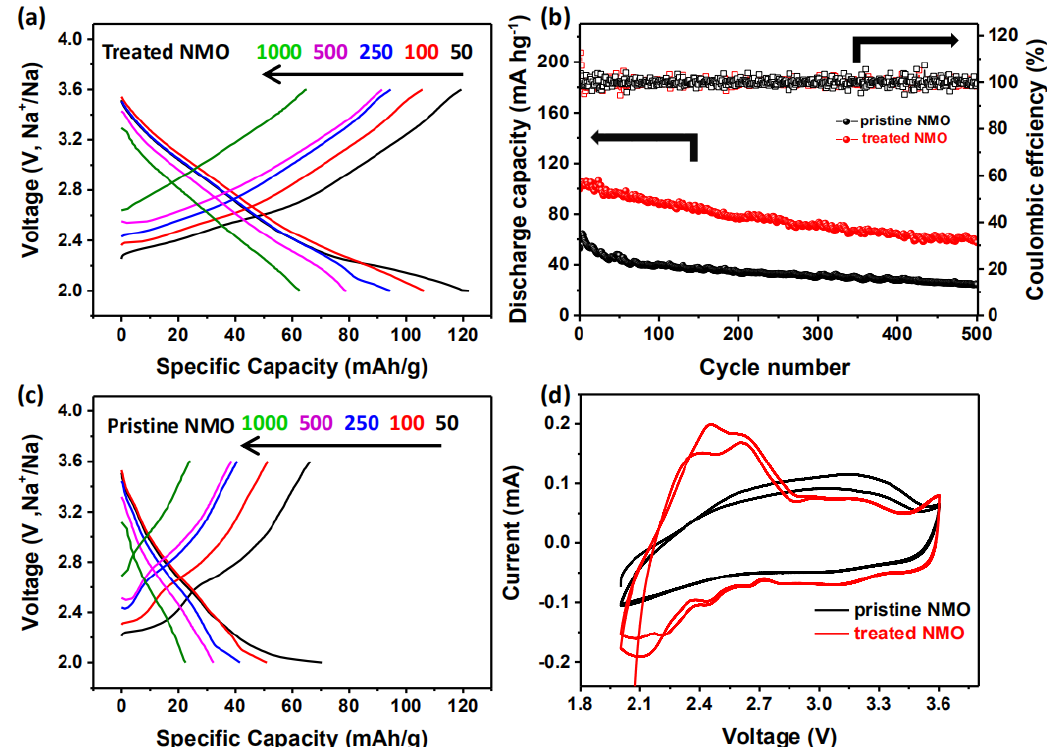
Figure 3. A series of electrochemical tests of NMO before and after treatment. ( a ), ( c ) Charge-discharge curves of NMO before and after treatment under different currents; ( b ) 500 cycles of charge and discharge of NMO before and after treatment at 50 mA / g current; ( d ) cyclic voltammetry curves of NMO before and after treatment.